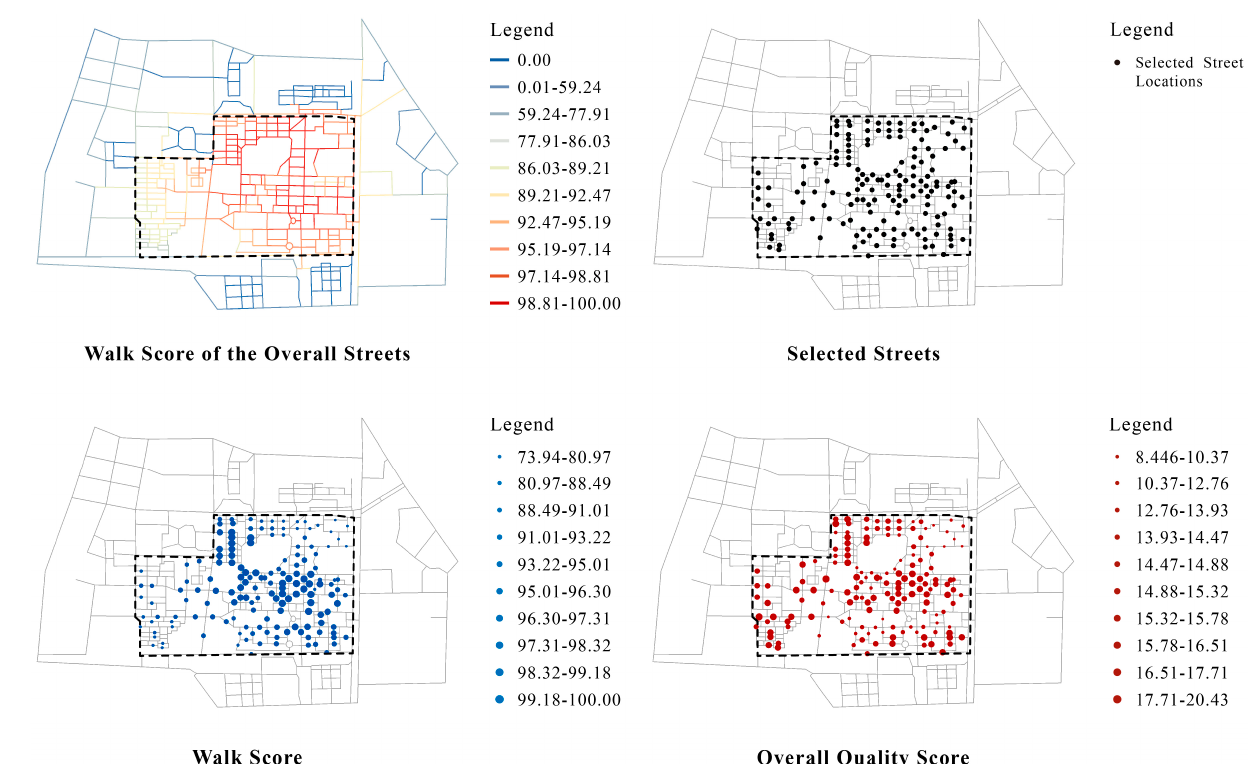
Figure 2. The location of the selected streets and their Walk Scores and overall quality.